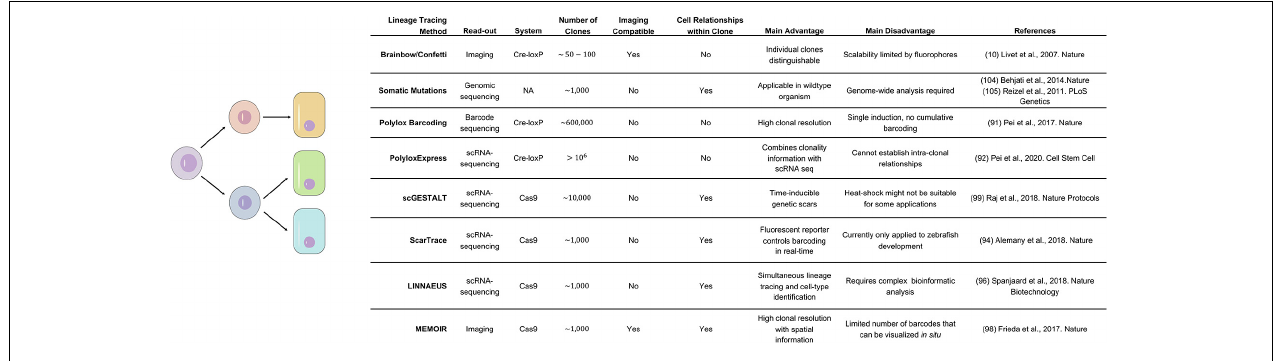
FIGURE 6 | Comparison of the main technologies available to perform lineage